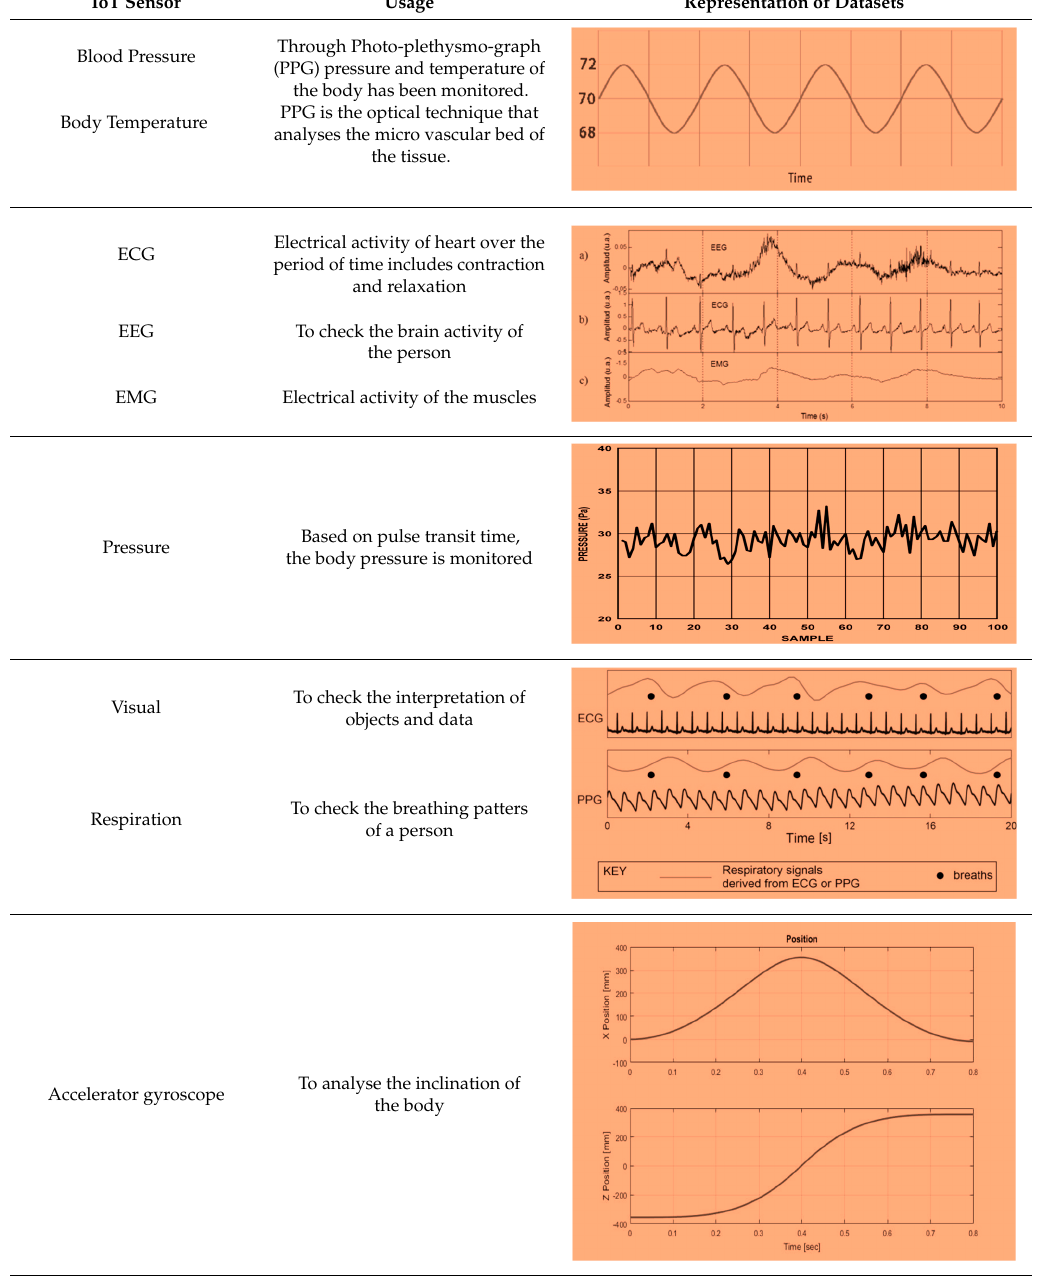
Table 1. IoT sensor signal estimation.